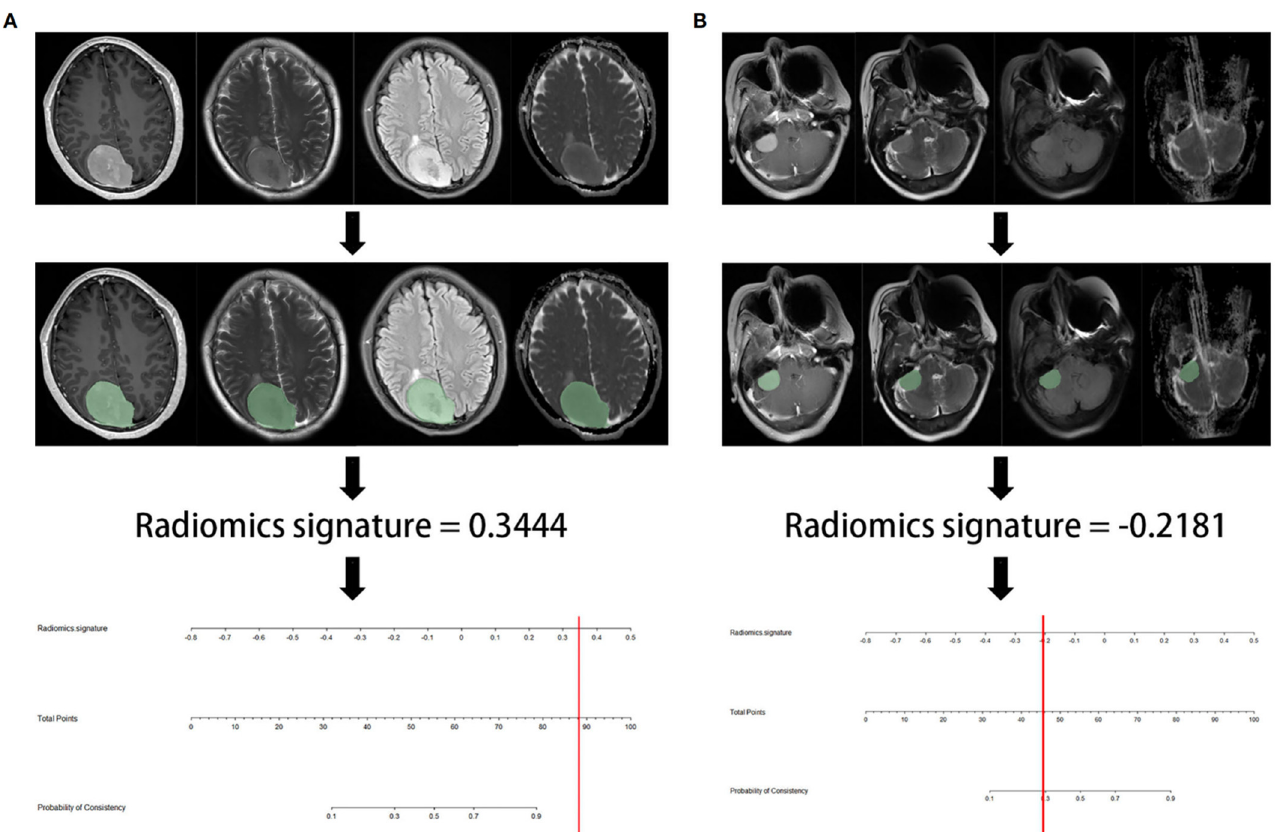
Figure 3. Representative flowchart and radiomics nomogram for meningioma consistency predic-